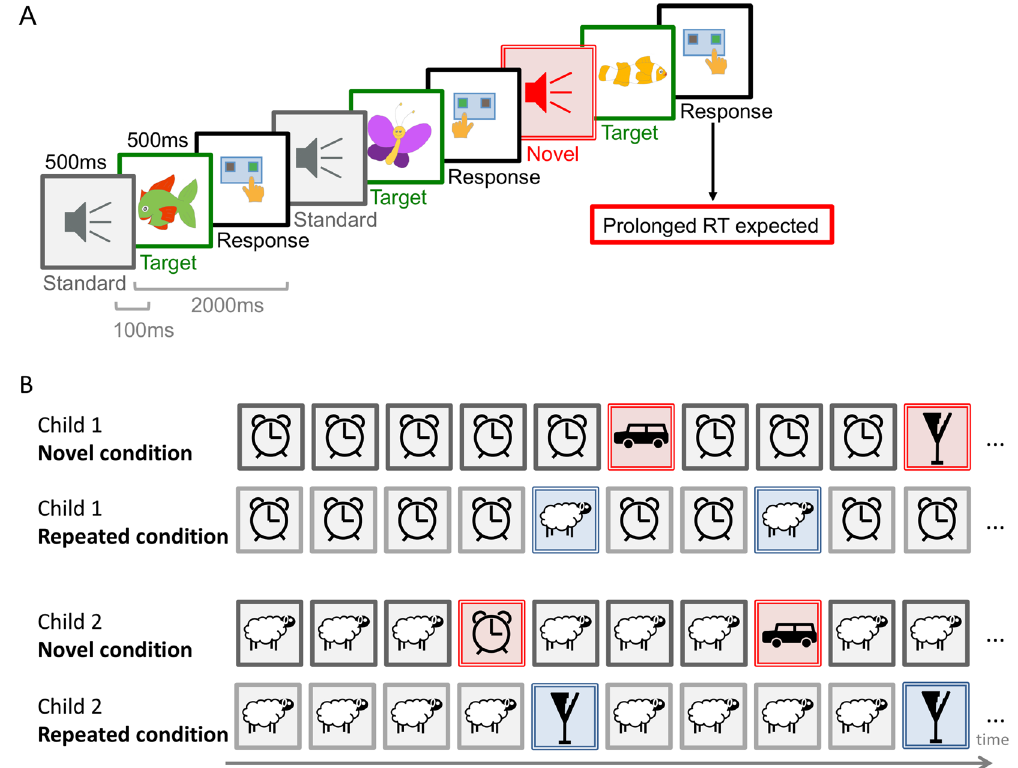
Figure 1. Distraction Paradigm . ( A ) Participants distinguished target categories by button press. In the displayed version they were asked to press the right button when a fish appears and the left button when a butterfly appears. Each target (green) was preceded by task-irrelevant sounds that could be either frequently presented standard sounds (grey) or rarely presented distractor sounds (new (red) or repeated (blue)). Distractor sounds delayed responses to the upcoming target. ( B ) Examples of sound sequences in the novel condition (different distractor sounds (red) were presented uniquely) and in the repeated condition (the same distractor sound (blue) was presented repeatedly). The standard sound varied between